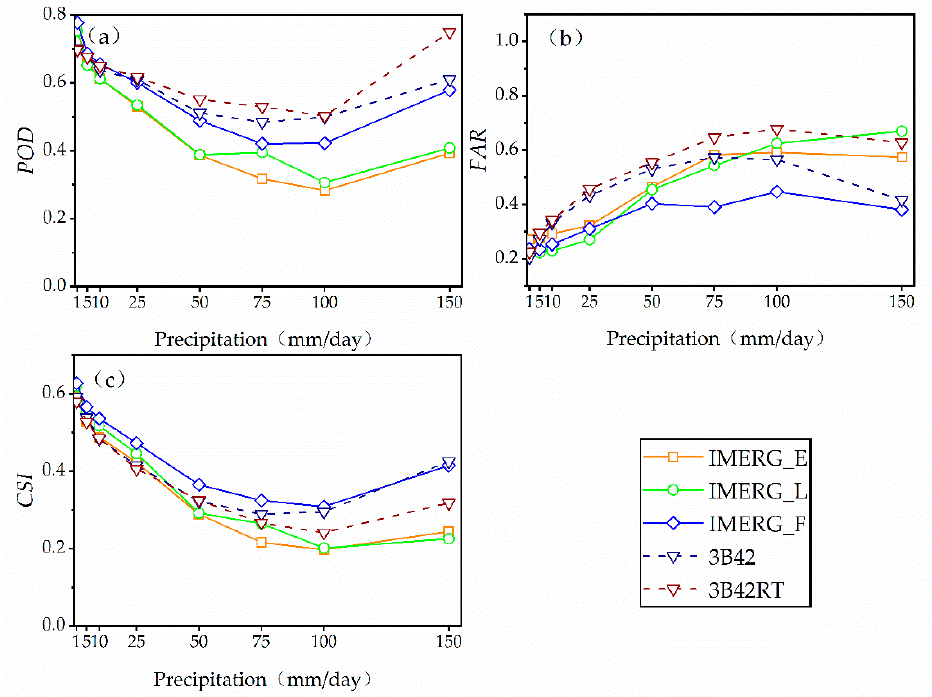
Figure 6. Comparison of the changes in annual categorical evaluation metrics with daily rainfall thresholds among five SPPs: ( a ) POD ; ( b ) FAR ; and ( c ) CSI .